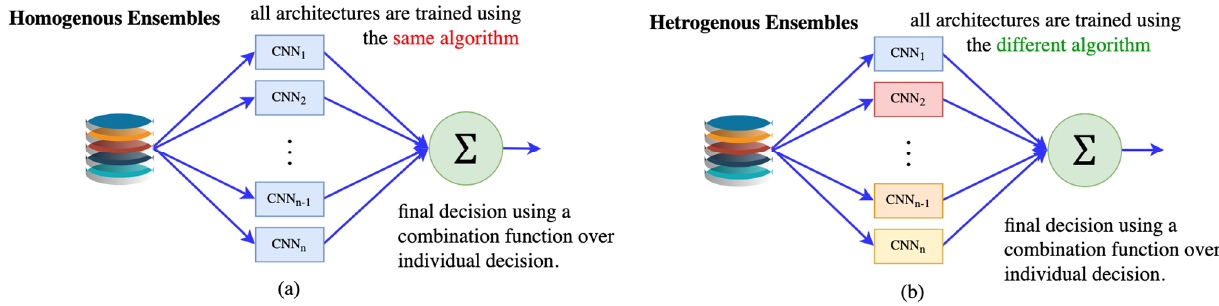
Figure 6. Examples of ( a ) homogenous and ( b ) heterogenous ensemble strategies.